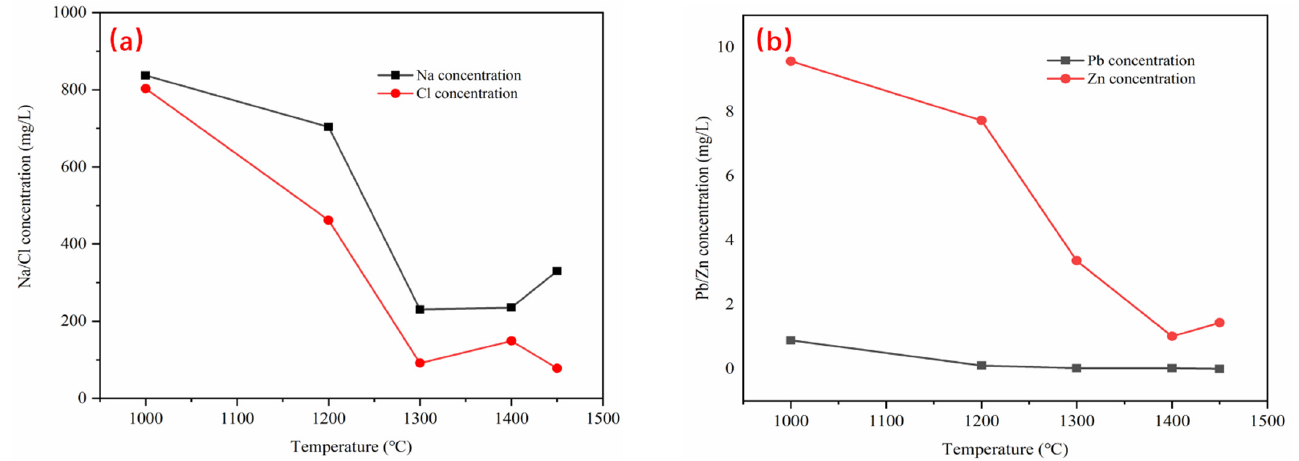
Figure 9. The acid leaching test results of slag at different temperatures: ( a ) Cl and Na contents in acid leaching solution; ( b ) Pb and Zn content in acid leaching solution.